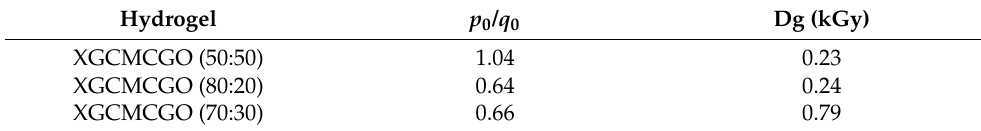
Table 1. Sol-gel parameters calculated according the Charlesby–Rosiak Equation (3).